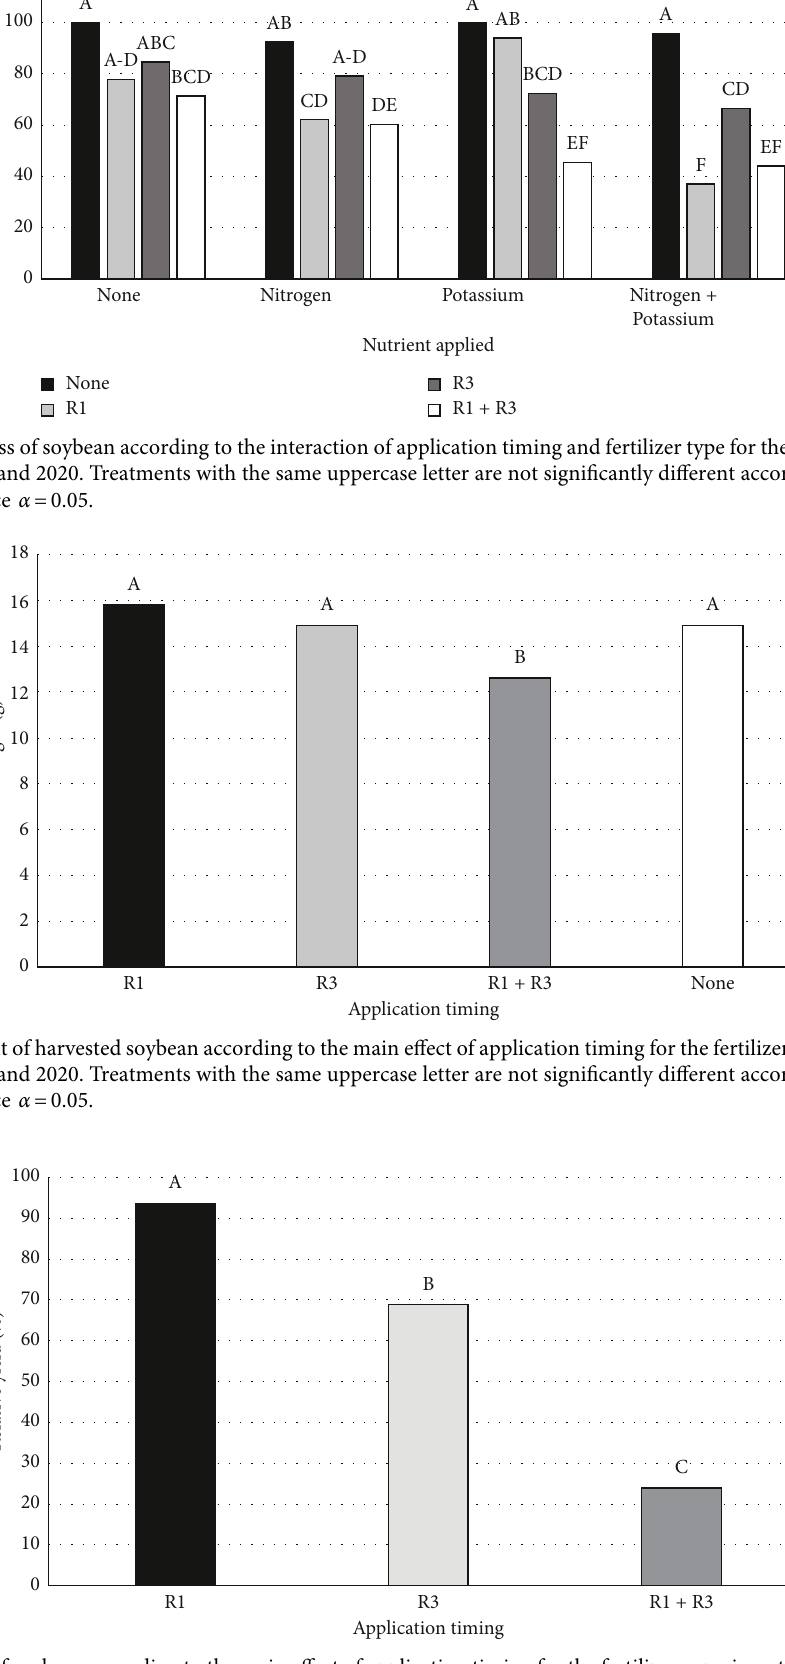
Figure 6: Relative yield of soybean according to the main effect of application timing for the fertilizer experiment conducted in Fayetteville, AR, in 2019 and 2020. Treatments with the same uppercase letter are not significantly different according to Fisher’s protected least significant difference α 0.05. (cid:29)